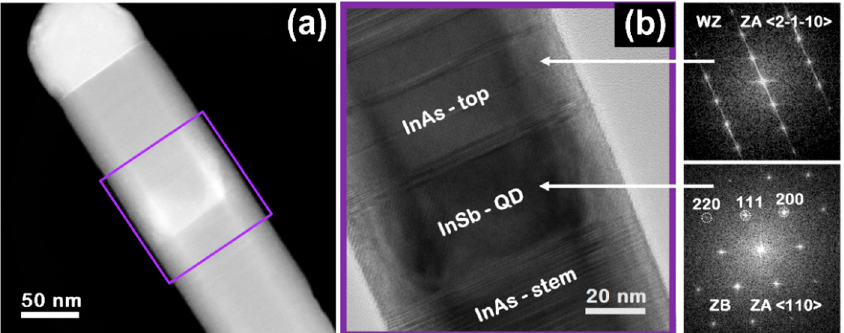
Figure 6. TEM analysis of a representative InSb/InAs QD NW. ( a ) high-angle annular dark field scanning transmission electron microscopy (HAADF-STEM) image, ( b ) high-resolution TEM (HR-TEM) image of the NW region framed by the purple square in panel ( a ). The fast Fourier transform (FFT) analysis shown on the bottom right confirms the ZB structure of the QD segment.